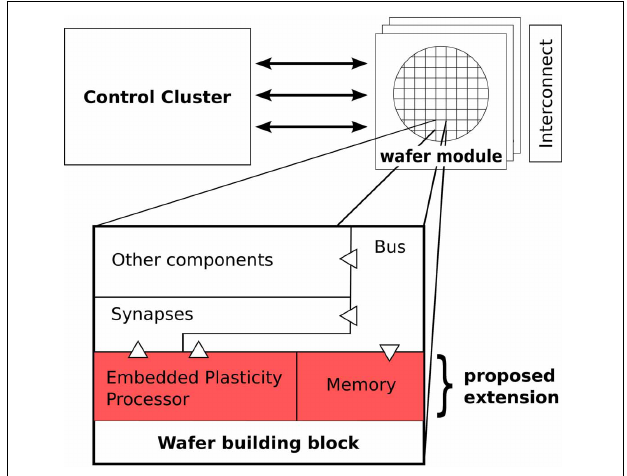
FIGURE 1 | Overview of the system. The user controls the system through a cluster of conventional computers by sending configuration and spike data to a number of modules that each carry a wafer. These wafer modules are interconnected with a high-speed network to exchange spike events. The wafer contains identical building blocks, of which one is shown in an expanded view. The proposed extension to the BrainScaleS wafer-scale system in form of the embedded plasticity processor is marked in red. Input/output access from the processor to other components of the building block is indicated with